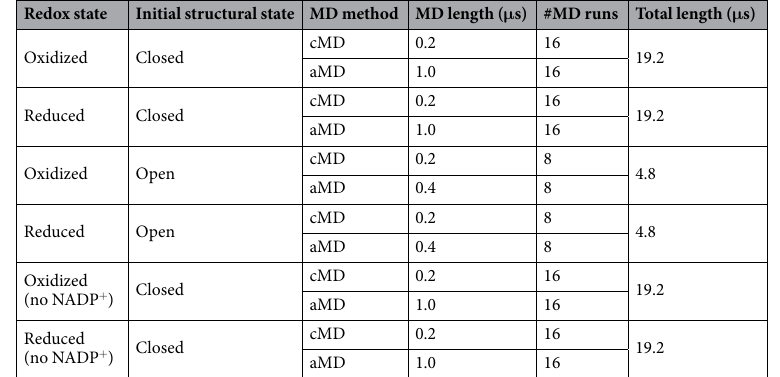
Table 1. MD runs conducted in this